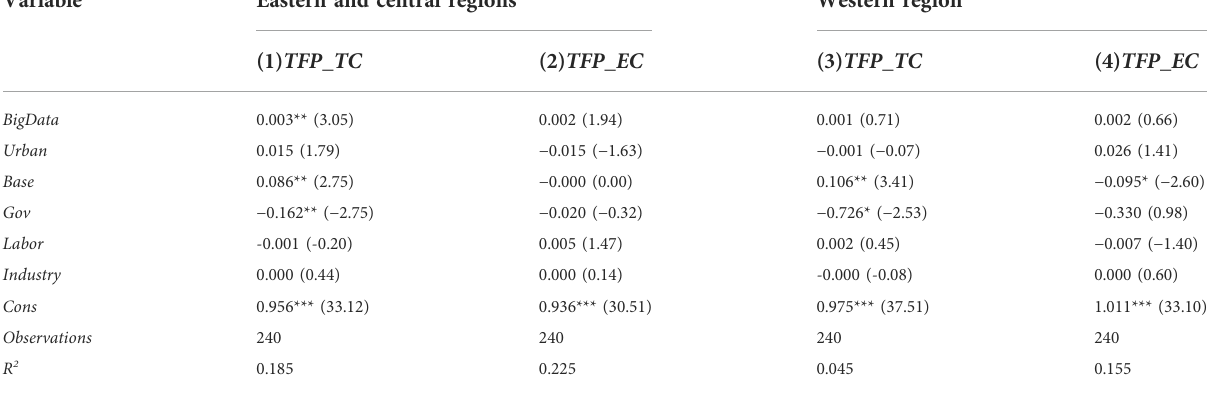
TABLE 5 Empirical results of geographical heterogeneity.